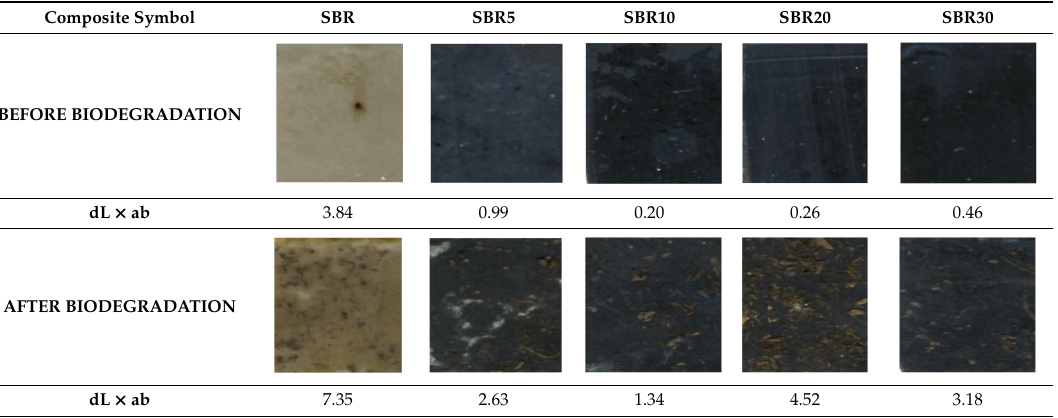
Table 5. Topography photos of surface changes of SBR composites before and after biodegradation